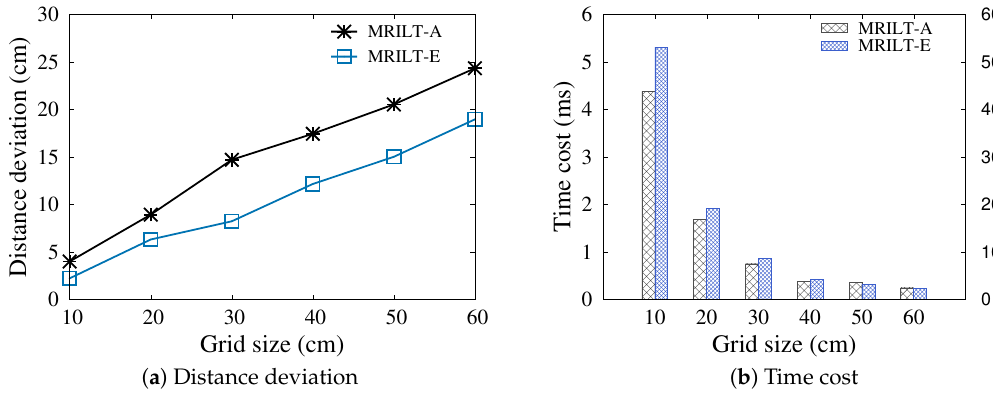
Figure 7. Varying grid size with δ d = 20 cm, δ s = 3 and σ = 0.1.